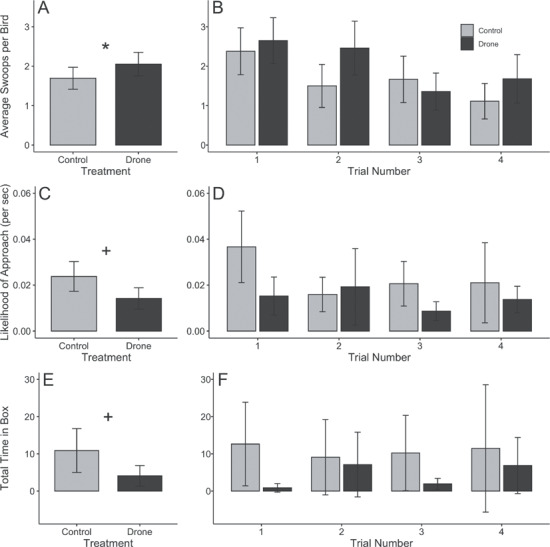
Behavioral trends between treatments. A significant difference in behavior between drone and control trials was observed for (A) average swoops per bird [(B) treatments split by trial]. Strong (P < 0.10), but non-significant, trends were observed for (C) likelihood of approaching the object [per unit time (s)] during drone and control trials [(D) treatments split by trial] and (E) total time in box during the trial [(F) treatments split by trial]. Means and confidence intervals are derived from raw data. * = P < 0.05, + = 0.05 < P < 0.10.